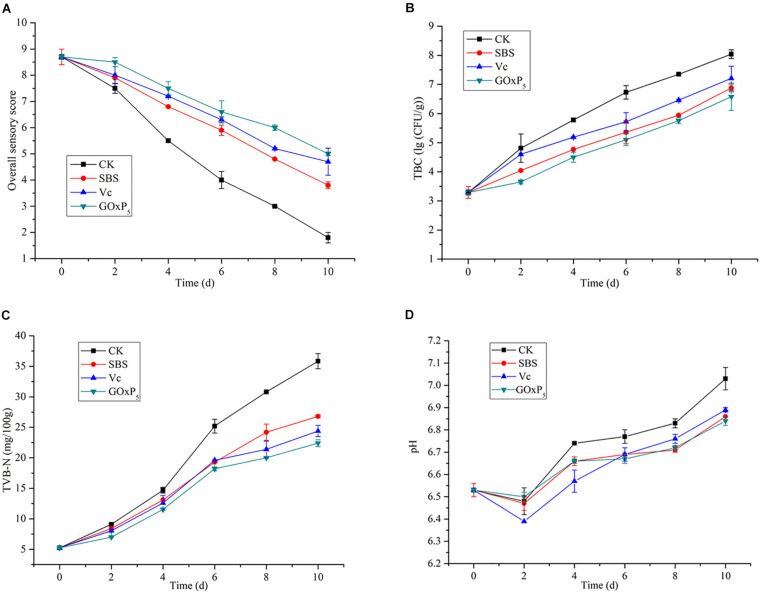
Changes in sensory quality (A), total bacterial counts (B), TVB-N (C), and pH (D) values of grass carp filets with different treatments of preservatives during storage at 4°C. The vertical bars represent the standard deviations (n = 2).